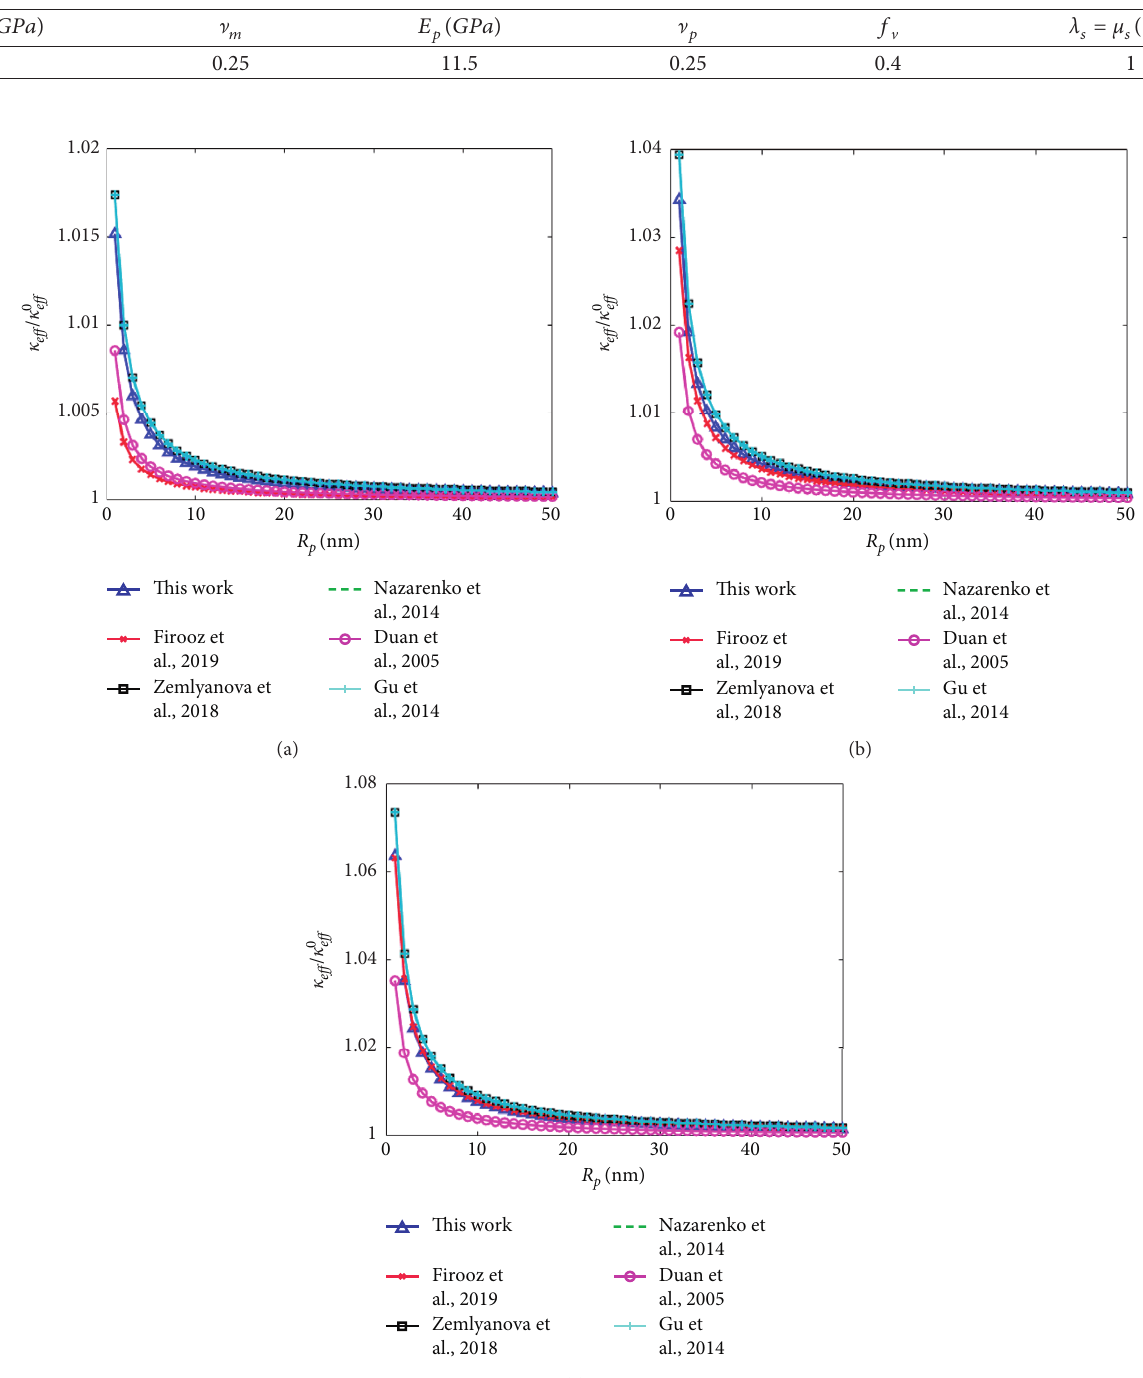
Table 2: Material properties used to compute the effective bulk modulus of 6